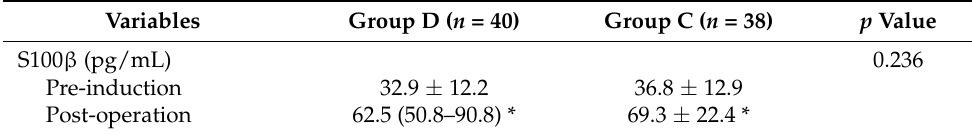
Table 3. Effects of dexmedetomidine on manifestation of S100 β